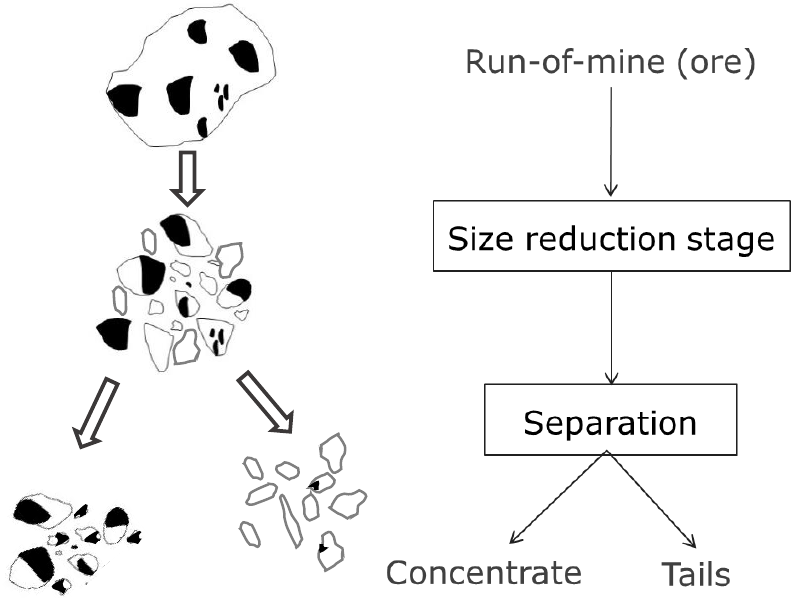
Figure 1. Mineral processing for metal-bearing ores.